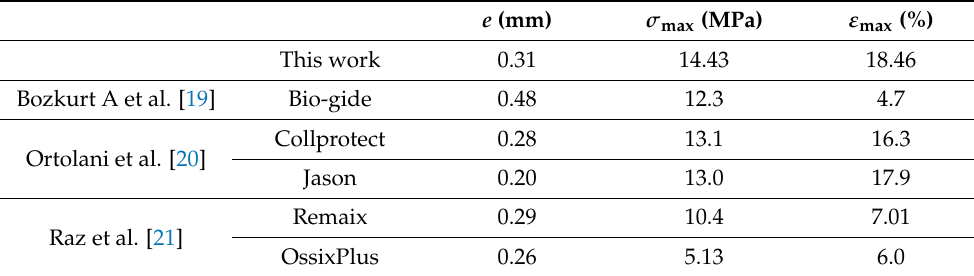
Table 4. Thickness ( e ), maximum tensile stress ( σ max ), and maximum tensile strain ( ε max ) of the membranes investigated in this work and of commercially available membranes.